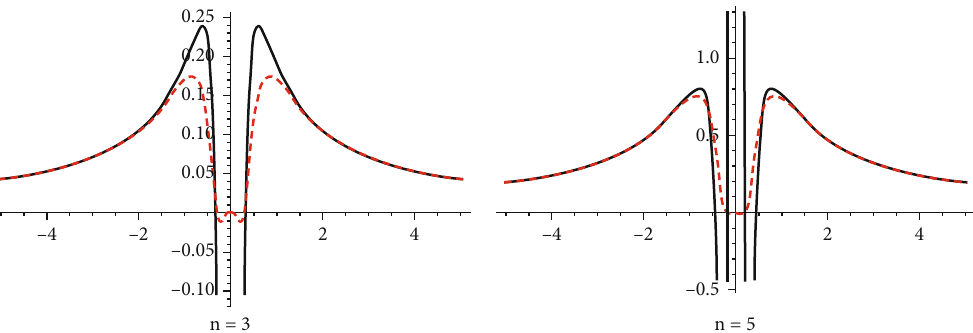
nz + 1 Þ for several values of n , whereas dashed lines represent the right-hand side of (34) with z ≡ x , both n ð − 1 where α = 0 : 2